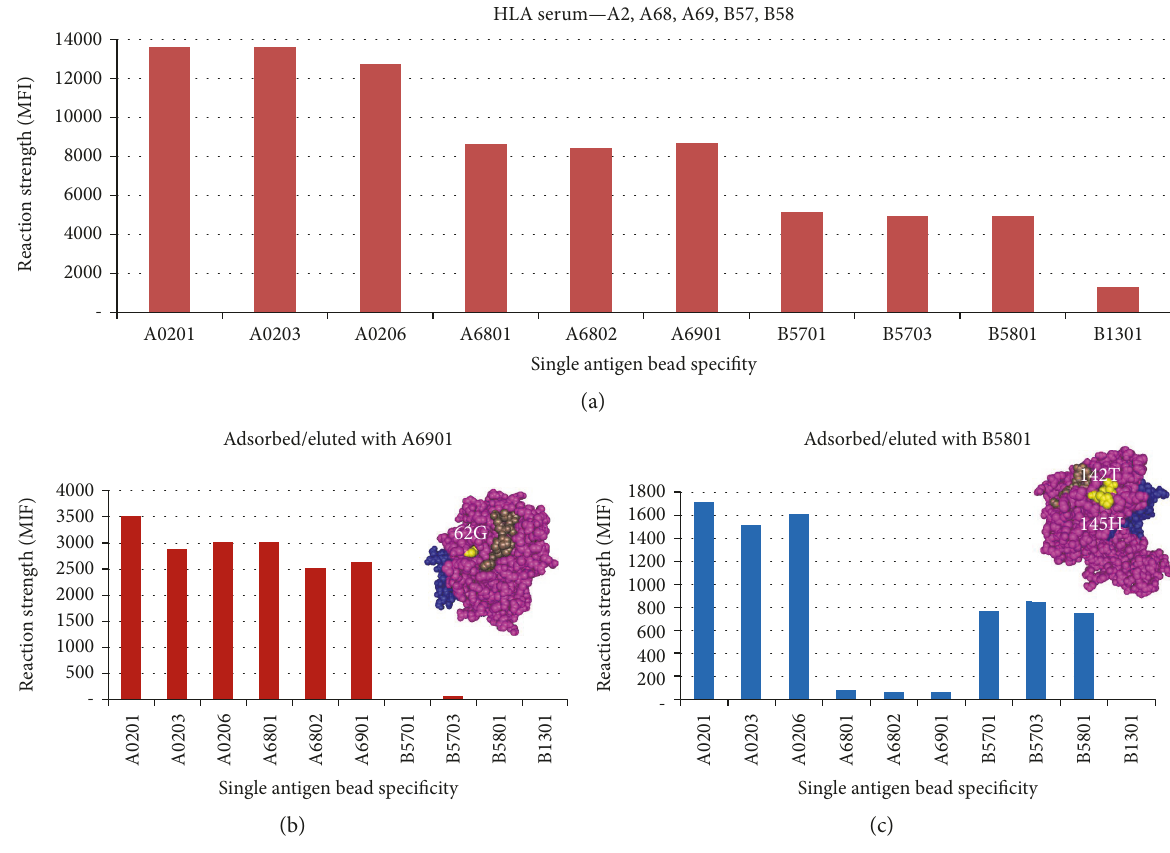
Figure 4: Alloserum with speci fi city A2, A68, A69, B57, and B58 (a). Antibody eluted from adsorption with A6901 recombinant cells has the speci fi city of A2, A68, and A69 (b). Antibody eluted from adsorption with B5801 recombinant cells has the speci fi city of A2, B57, and 58 (c). Table 2: Epitopes on intact antigens targeted by naturally occurring antibodies — partial list. Complete list in supplemental fi